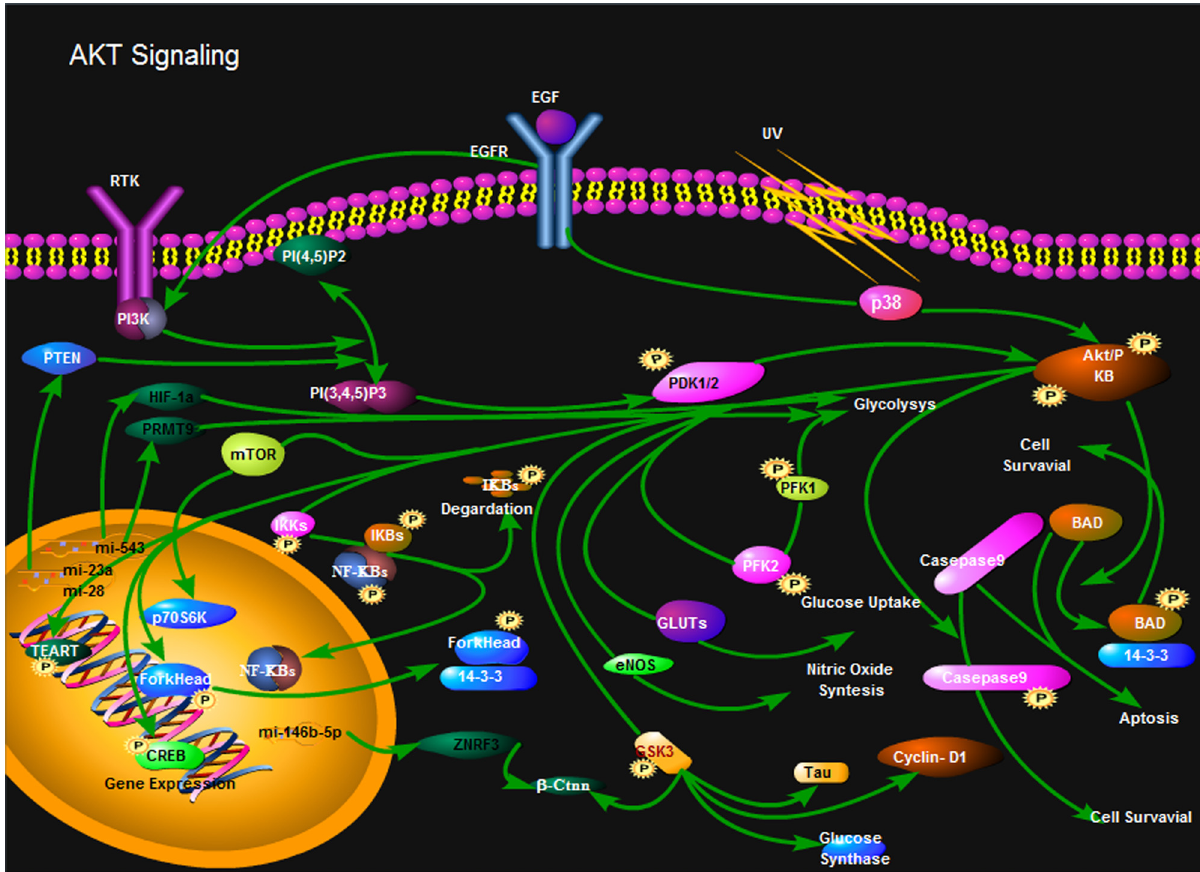
Figure 1: miRNA - 23a can enhance the metastasis and invasion of OS cells by upregulating the signal expression of PTEN signaling